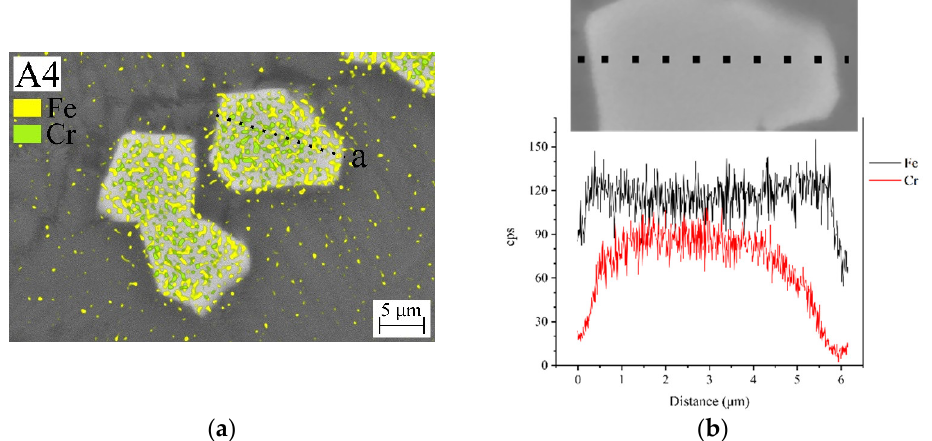
Figure 4. Distribution of Fe and Cr elements in the spine phase in Sample A4 according to EDS mapping results. ( a ) Surface scanning result of area “A” in Figure 2d; ( b ) line scanning result of line “a” in Figure 2e.